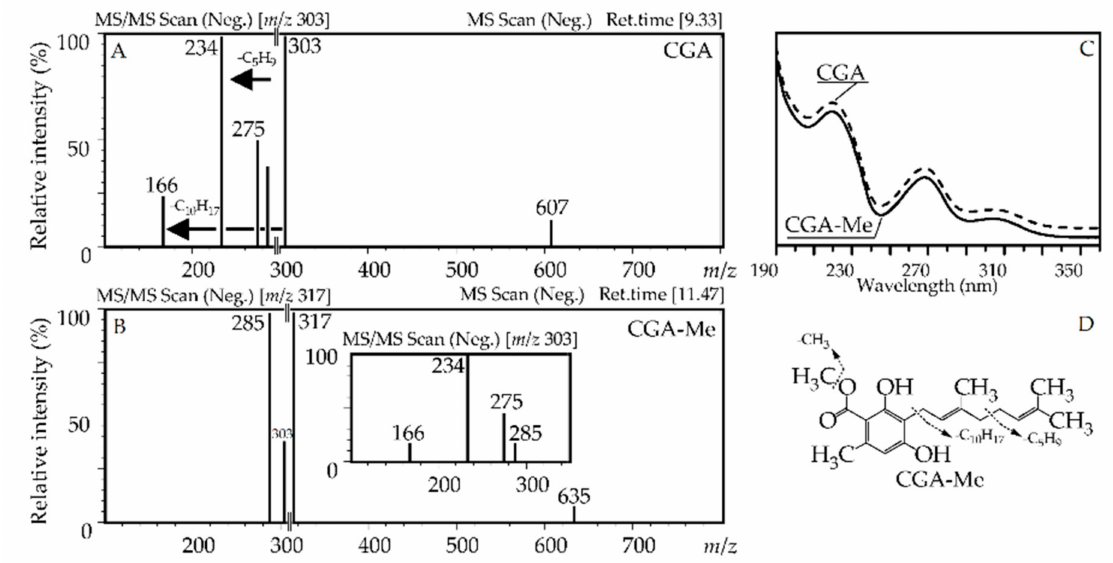
Figure 6. Mass spectra ( A , B ); negative ionization), UV patterns ( C ) of cannabigerorcinic acid (CGA) and cannabigerorcinic acid methyl ester (CGA-Me), and fragmentation way of CGA-Me ( D